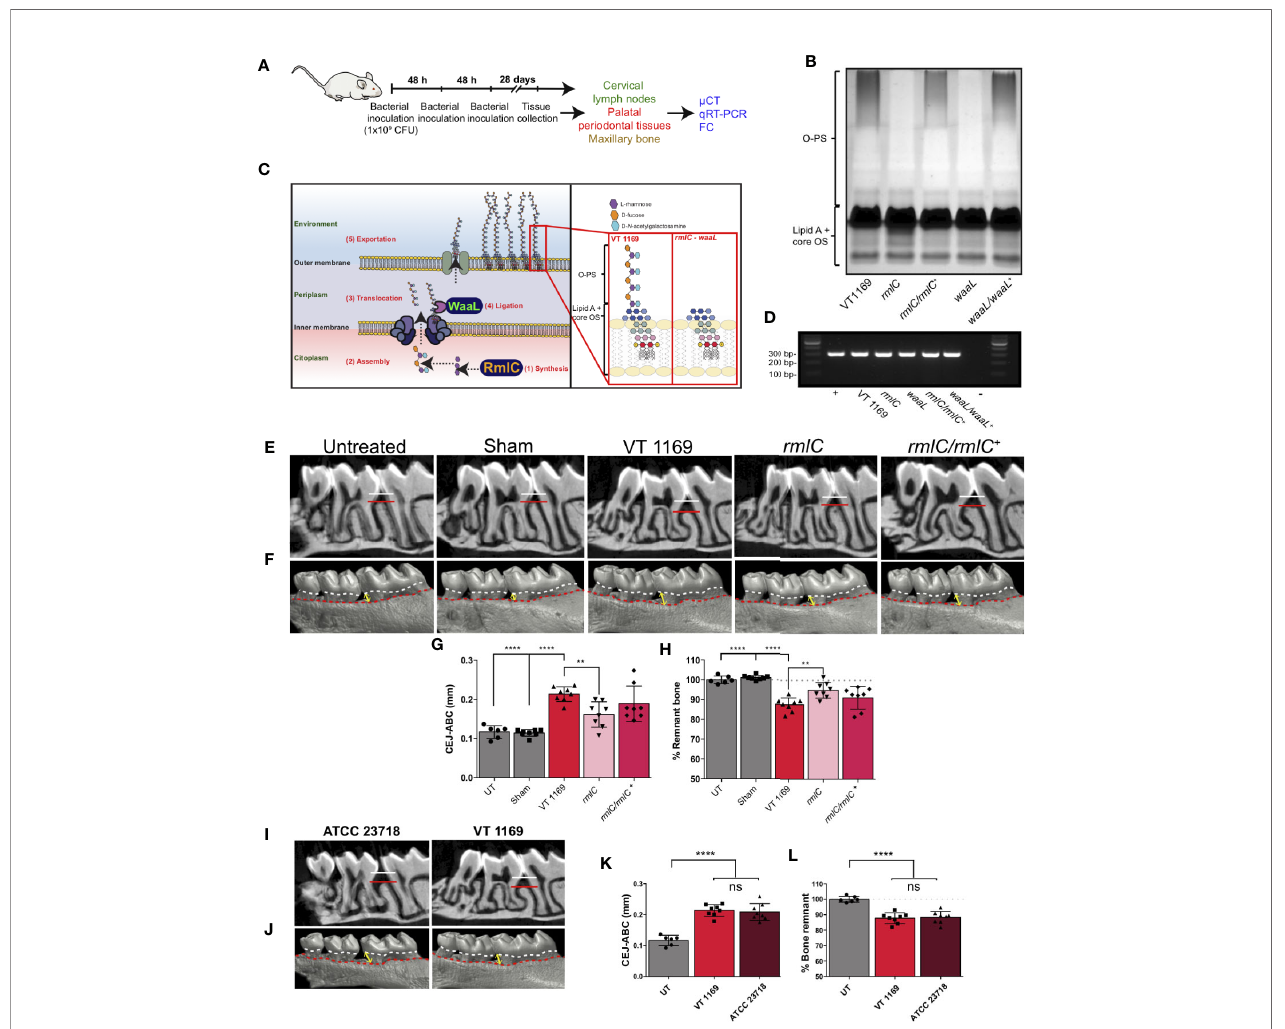
FIGURE 1 | Lipopolysaccharide (LPS) analysis and alveolar bone loss triggered by the different strains of A. actinomycetemcomitans . (A) Diagram illustrating the protocol for the bacteria-induced periodontitis model. (B) LPS pro fi les obtained by SDS-PAGE analysis of the VT1169 wild-type strain and the rmlC and waaL mutant strains, as well as the rmlC/rmlC + and waaL/waaL + complemented strains. (C) Schematic view of the A. actinomycetemcomitans serotype b O- polysaccharide (O-PS) biosynthetic pathway, highlighting the modi fi ed enzymes and the O-PS pro fi le obtained by Tang et al. (26) and used in the present study. (D) The 2% agarose gel of the ampli fi cation products obtained with speci fi c primers for the strain VT1169, from PCR analysis of the V3-V6 variable region of the 16S rDNA. (E) Sagittal slices of the 2D-reconstruction by m CT showing the alveolar bone loss determined as the CEJ-ABC linear distance in the interdental area between the fi rst and second molar (white-red lines) in mice infected with the A. actinomycetemcomitans VT1169, rmlC , or rmlC/rmlC + strains and the sham-infected and untreated controls. (F) Vestibular view of the 3D-reconstruction by m CT showing the alveolar bone loss, determined as the CEJ-ABC linear distance in the distal surface of the distal root of the fi rst molar in the same experimental conditions described in (E) . Yellow double-arrow lines represent the CEJ-ABC linear distance (CEJ marked as a dashed white line and ABC marked as a dashed red line). (G) Quanti fi cation of the alveolar bone loss determined as the CEJ-ABC linear distance in the distal surface of the distal root of the fi rst molar in mice infected with the A. actinomycetemcomitans VT1169, rmlC , or rmlC/rmlC + strains and the sham- infected and untreated controls (UT). (H) Quanti fi cation of the alveolar bone loss determined as the percentage of remnant alveolar bone in mice infected with the A. actinomycetemcomitans VT1169, rmlC , or rmlC/rmlC + strains and the sham-infected and UT controls, considering the average of remnant alveolar bone in UT mice as 100%. (I) Sagittal slices of the 2D-reconstruction by m CT showing the alveolar bone loss determined as the CEJ-ABC linear distance in the interdental area between the fi rst and second molar (white-red lines) in mice infected with the A. actinomycetemcomitans VT1169 and ATCC 23718 strains. (J) Vestibular view of the 3D-reconstruction by m CT showing the alveolar bone loss, determined as the CEJ-ABC linear distance in the distal surface of the distal root of the fi rst molar in the same experimental conditions described in (I) . Yellow double-arrow lines represent the CEJ-ABC linear distance (CEJ marked as a dashed white line and ABC marked as a dashed red line). (K) Quanti fi cation of the alveolar bone loss determined as the CEJ-ABC linear distance in the distal surface of the distal root of the fi rst molar in mice infected with the A. actinomycetemcomitans VT1169 and ATCC 23718 strains and UT controls. (L) Quanti fi cation of the alveolar bone loss determined as the percentage of remnant alveolar bone in mice infected with the A. actinomycetemcomitans VT1169 and ATCC 23718 strains and UT controls, considering the average of remnant alveolar bone in UT mice as 100%. Mean ± SD, one-way ANOVA and Tukey post-hoc test, **p < 0.01, ****p < 0.0001. Error bars represent SEM in all panels. ABC, alveolar bone crest; CEJ, cement-enamel junction; CFU, colony-forming units; cLNs, cervical lymph nodes; FC, fl ow cytometry; ns, no signi fi cant; LPS, lipopolysaccharide; O-PS, O-polysaccharide; OS, oligosaccharide; PPTs, palatal periodontal